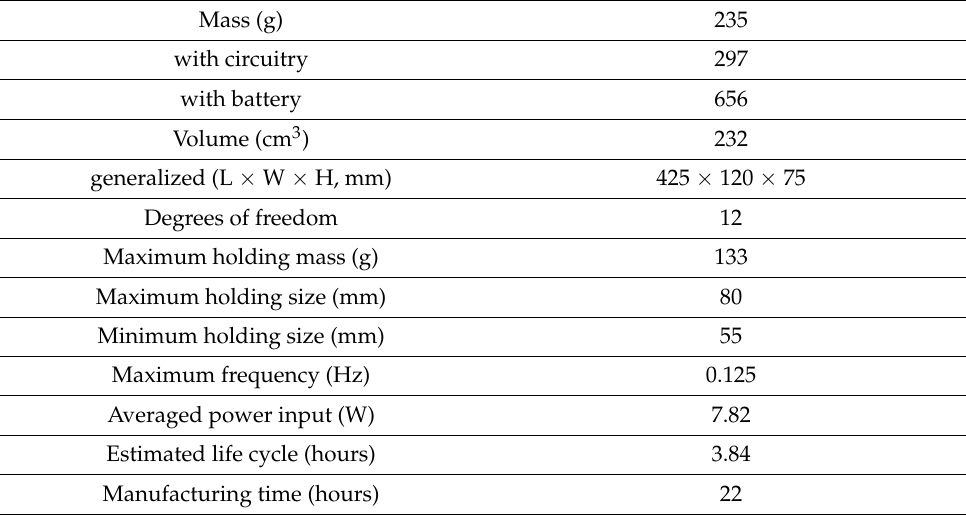
Table 4. Summary of the robotic hand